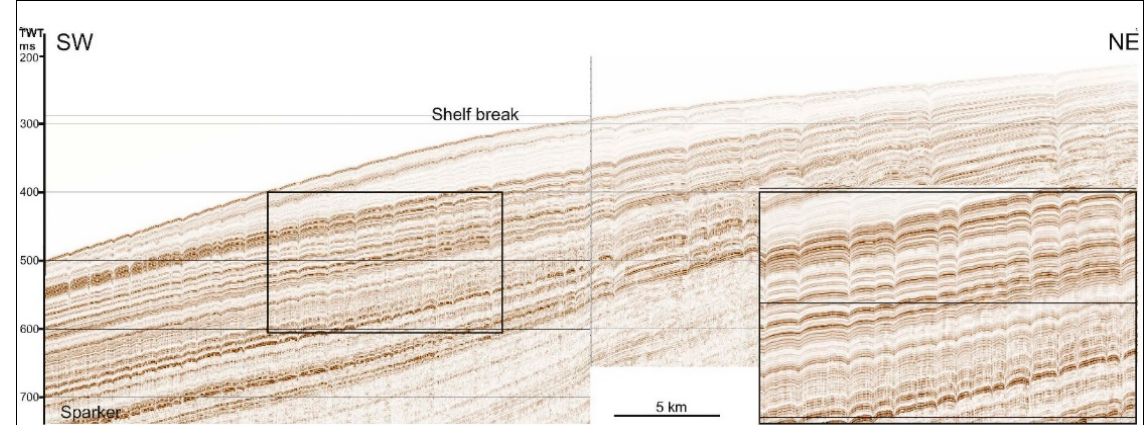
Figure 15. Exogenic–gravitational folds or creep deformation on the eastern slope of the Derbent Basin. Fragment of the profile (sparker) SW-NE trending across foot of the slope. Location of the piles is shown in Figure 2.